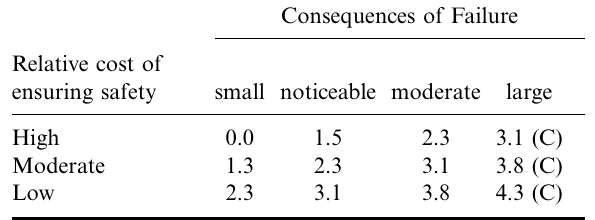
Table 6. Reliability indices obtained in the probabilistic